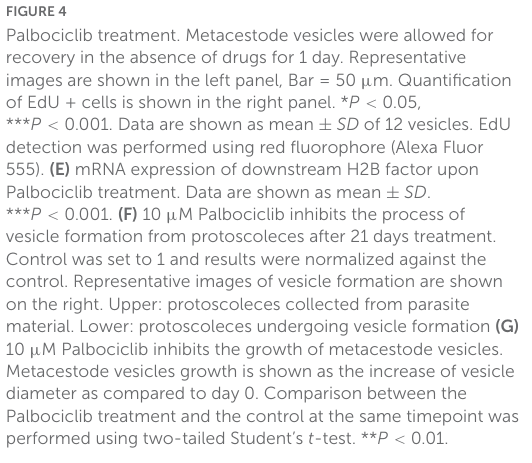
FIGURE4 Palbociclib treatment. Metacestode vesicles were allowed for recovery in the absence of drugs for 1 day. Representative images are shown in the left panel, Bar = 50 µ m. Quantification of EdU + cells is shown in the right panel. * P < 0.05, *** P < 0.001. Data are shown as mean ± SD of 12 vesicles. EdU detection was performed using red fluorophore (Alexa Fluor 555). (E) mRNA expression of downstream H2B factor upon Palbociclib treatment. Data are shown as mean ± SD . *** P < 0.001. (F) 10 µ M Palbociclib inhibits the process of vesicle formation from protoscoleces after 21 days treatment. Control was set to 1 and results were normalized against the control. Representative images of vesicle formation are shown on the right. Upper: protoscoleces collected from